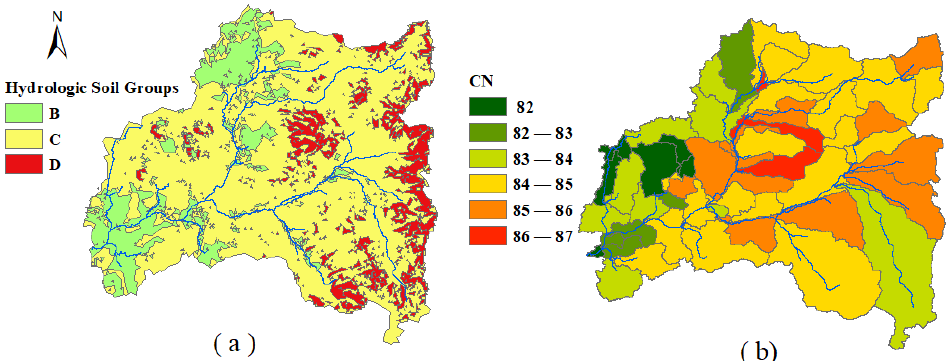
Figure 7. Soil and land use data for HEC-HMS model, ( a ) hydrologic soil groups, ( b ) the CN values for the sub-basins.